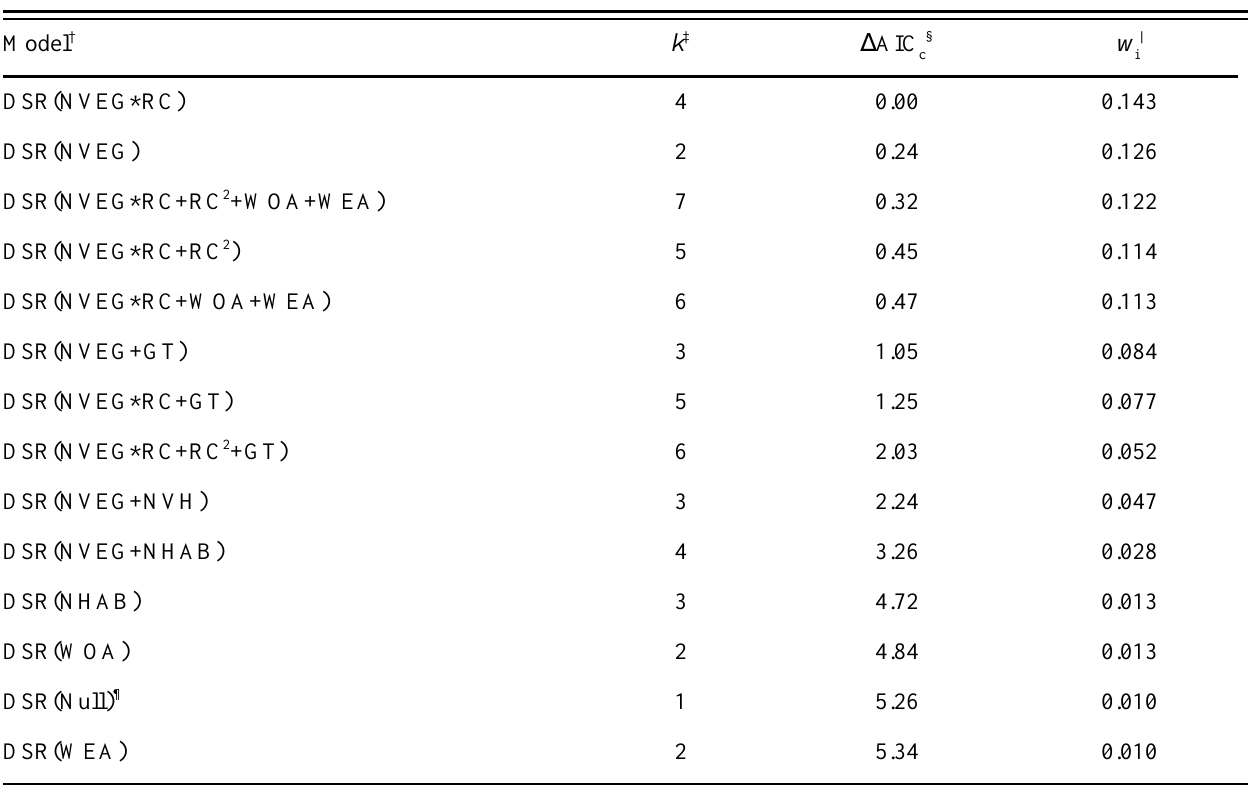
Table 2 . Rankings of duck nest daily survival rate (DSR) models investigating effects of habitat and grazing co-variates. Habitat co-variates include grass type (GT), nest habitat (NHAB), woodland area (WOA), and wetland area (WEA); grazing co-variates are nest-site vegetation density (NVEG), nest-site vegetation height (NVH), and residual cover (RC) co-variates. Models are nonlinear mixed effects models with a binomial error distribution ( n = 633 nest-fate intervals). Only models within the 95% confidence interval group of models, i.e., S w = 0.95, are presented (Burnham and Anderson 1998). i Model † k ‡ D AIC c§ w i| DSR(NVEG*RC) 4 0.00 0.143 DSR(NVEG) 2 0.24 0.126 DSR(NVEG*RC+RC 2 +WOA+WEA) 7 0.32 0.122 DSR(NVEG*RC+RC 2 ) 5 0.45 0.114 DSR(NVEG*RC+WOA+WEA) 6 0.47 0.113 DSR(NVEG+GT) 3 1.05 0.084 DSR(NVEG*RC+GT) 5 1.25 0.077 DSR(NVEG*RC+RC 2 +GT) 6 2.03 0.052 DSR(NVEG+NVH) 3 2.24 0.047 DSR(NVEG+NHAB) 4 3.26 0.028 DSR(NHAB) 3 4.72 0.013 DSR(WOA) 2 4.84 0.013 DSR(Null) ¶ 1 5.26 0.010 2 5.34